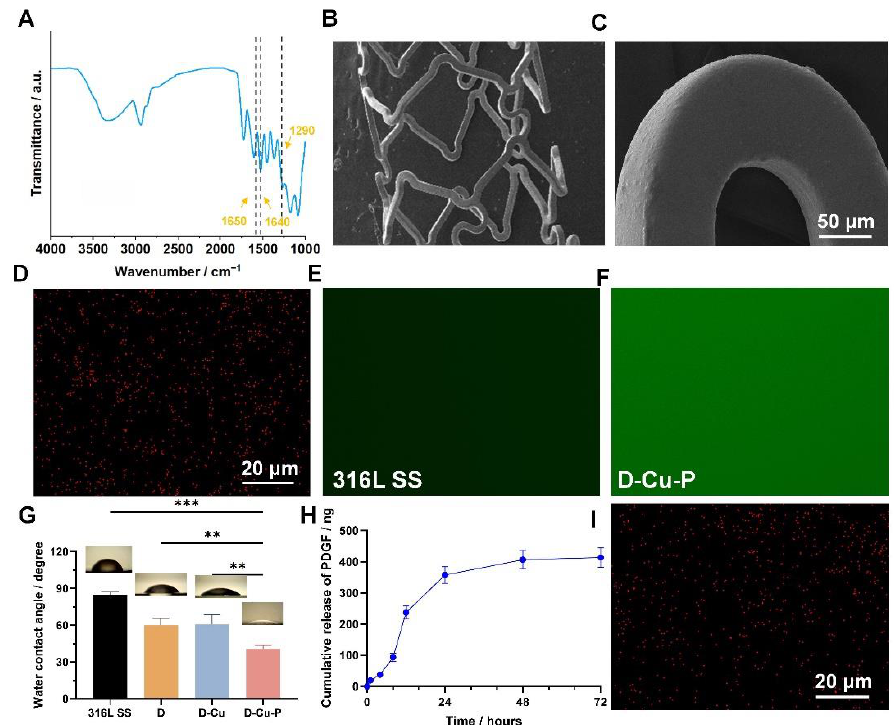
Figure 2. The evaluation of the surface modification of the 316L SS foils. ( A ) FTIR spectra of the synthesized DMHM (the dotted line indicated the position of specific peaks). ( B , C ) SEM evaluation of the stents after DMHM and Cu II coating. ( D ) The EDX evaluation of the Cu element on the DMHM- and Cu II -coated samples. ( E , F ) The evaluation of the PDGF immobilization through the fluorescence intensity of FITC-BSA. ( G ) The contact angle evaluation of the prepared coatings. ( H ) The cumulative PDGF release of the PDGF immobilization samples. ( I ) The EDX evaluation of the Cu element after 2 months. ** p < 0.01 and *** p < 0.001 denote the statistical significance. Table 1. The relative chemical compositions of the DMHM-Cu II coating initially and after 2 months. Time